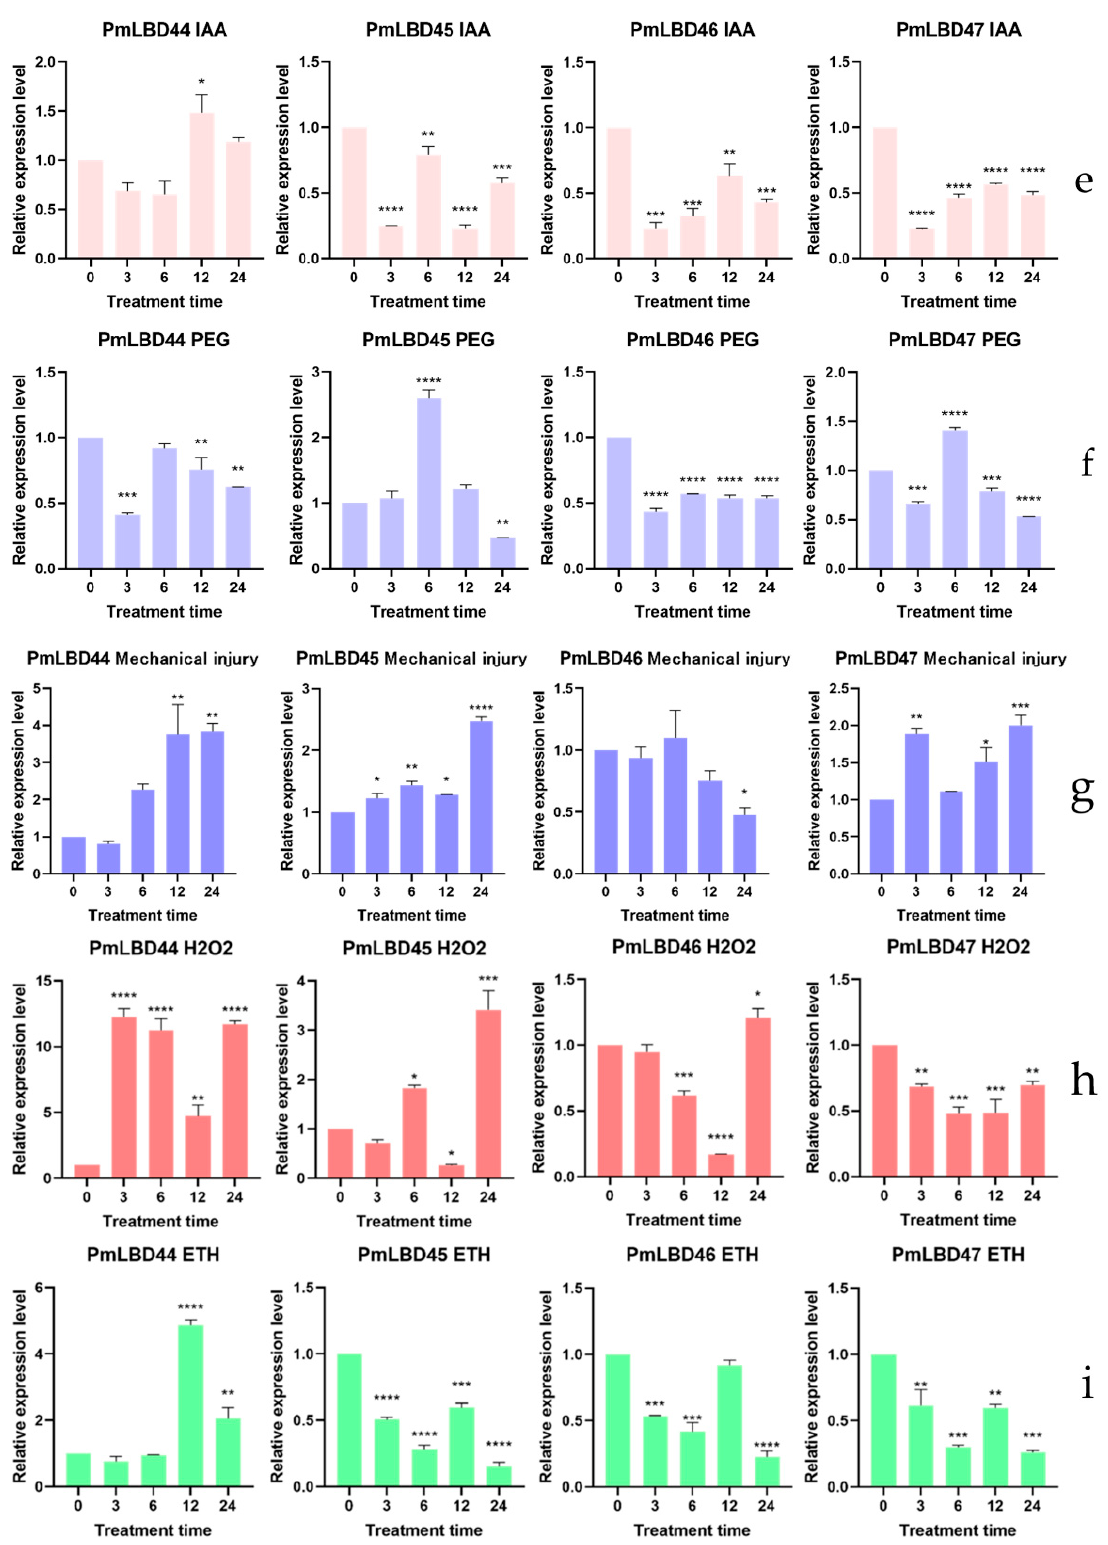
Figure 7. Effect of different treatments associated with pine nematode infection on LBD gene expression. ( a ) ABA, ( b ) NaCl, ( c ) MeJA, ( d ) SA, ( e ) IAA, ( f ) PEG, ( g ) Mechanical Injury, ( h ) H 2 O 2 , ( i ) ETH. Asterisks indicate significant differences in transcript abundance in the treated group compared to the control group (0 h) (* p < 0.05, ** p < 0.01, *** p < 0.001, **** p < 0.0001).